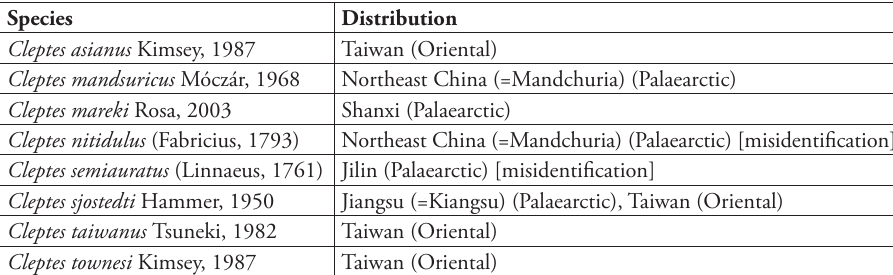
table 1. List of the Chinese species of Cleptinae before this study. Species Distribution Cleptes asianus Kimsey, 1987 Taiwan